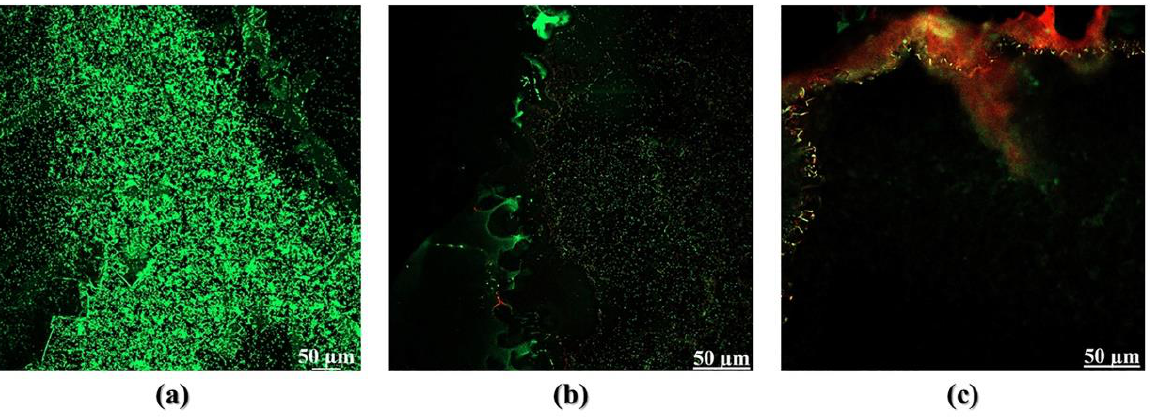
Figure 10. ( a ) Confocal images of P. aeruginosa PAO1 biofilms stained with Syto-9 (green) live stain and Propidium iodide (red) dead stain in negative control sample, ( b ) PAO1 biofilm incubated with 3 µM GaPP for 2 h and photoactivated with 34.2 J. cm − 2 , ( c ) PAO1 biofilm incubated with 3 µM GaPP-LCNP for 2 h and photoactivated with 34.2 J. cm − 2 .